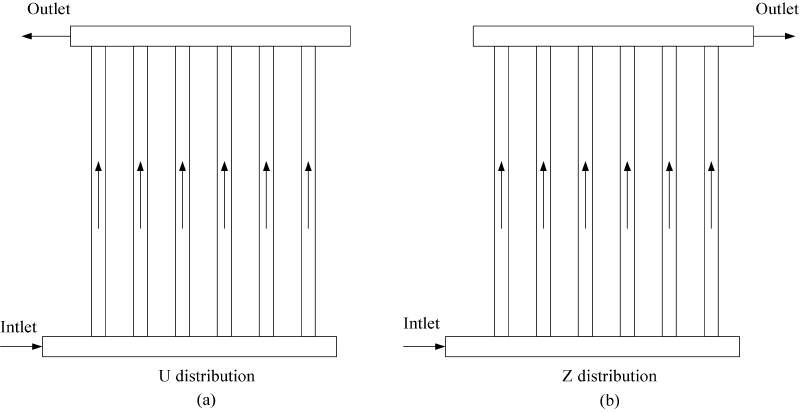
Figure 1. Arrangement of a flat plate solar collector. ( a ) U distribution; ( b ) Z